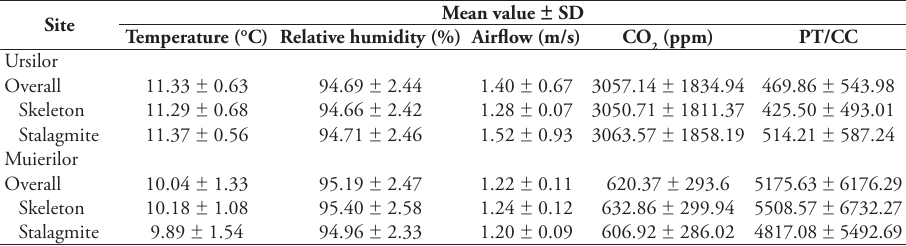
Table 1. Mean values of environmental parameters over the course of the study period. SD, Standard deviation; PT/CC, particles per cubic centimetre of air.